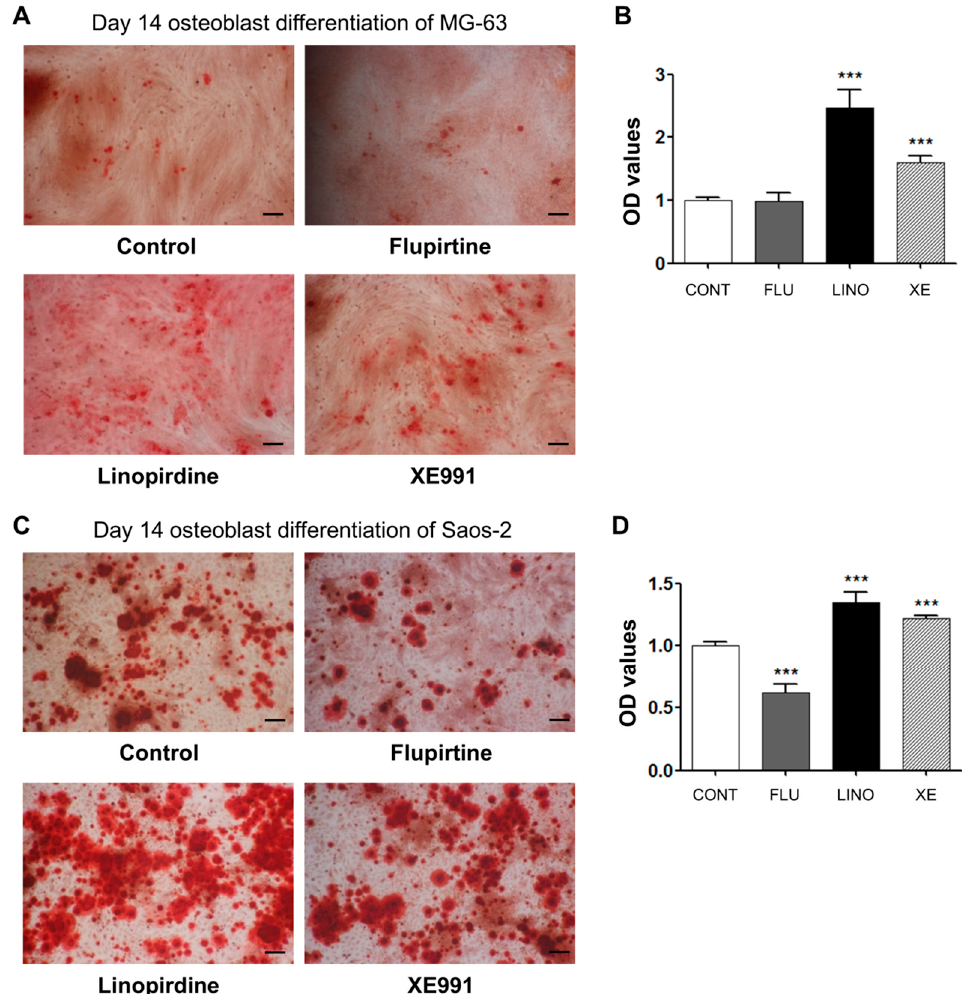
Figure 6. Regulation of osteoblastic differentiation by K V 7 channel in MG-63 and Saos-2 cells. ( A ) Alizarin Red S staining data showed that 30 μ M of linopirdine and 10 μ M of XE991 augmented mineralization in the extracellular matrix in MG-63 cells ( n = 10). There was no significant change in the mineralized matrix with 30 μ M of flupirtine ( n = 3); ( B ) The OD values demonstrated that linopirdine and XE991 increased the amount of calcium deposits; ( C ) Alizarin Red S staining illustrated that mineralization of Saos-2 cells was increased with 30 μ M of linopirdine and 10 μ M of XE991 ( n = 8), while 30 μ M of flupirtine reduced the amount of calcium deposits ( n = 7); ( D ) The OD values are shown parallel to Alizarin Red S staining results. Data are presented as mean ± SEM. *** p < 0.005. Scale bar represents 100 μ m. CONT: non-treated controls; FLU: flupirtine; LINO: linopirdine; XE: XE991; OD: optical density.